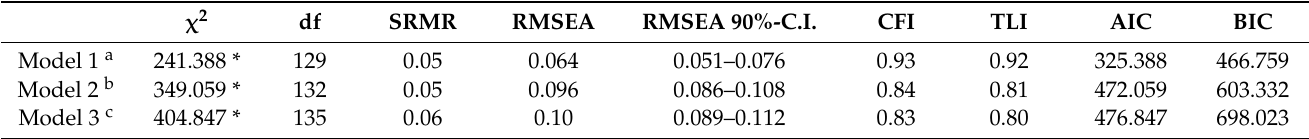
Table 2. Fit indexes for models tested in CFA (Study